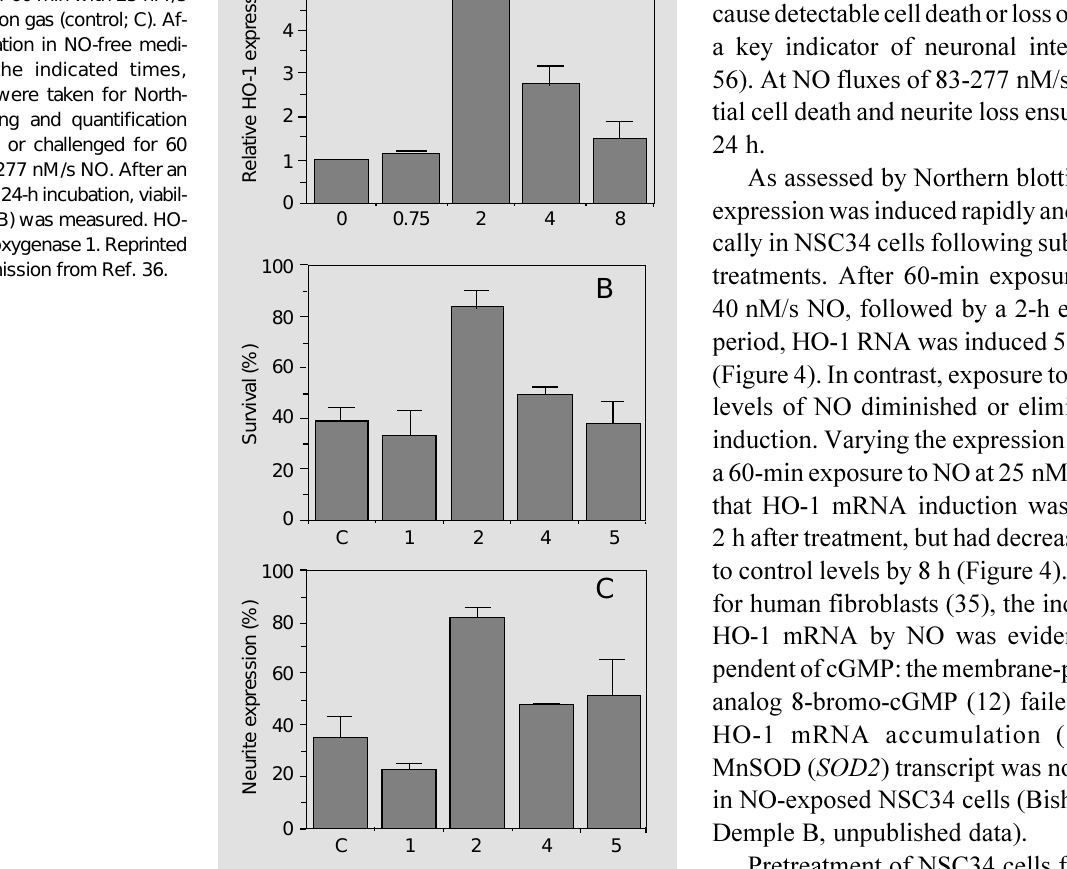
4 - Kinetics of adaptive nitric oxide (NO) resistance in NSC34 cells. The cells were pre- treated for 60 min with 25 nM/s NO or argon gas (control; C). Af- ter incubation in NO-free medi- um for the indicated times, samples were taken for North- ern blotting and quantification (panel A), or challenged for 60 min with 277 nM/s NO. After an additional 24-h incubation, viabil- ity (panel B) was measured. HO- 1, Heme oxygenase 1. Reprinted with permission from Ref.